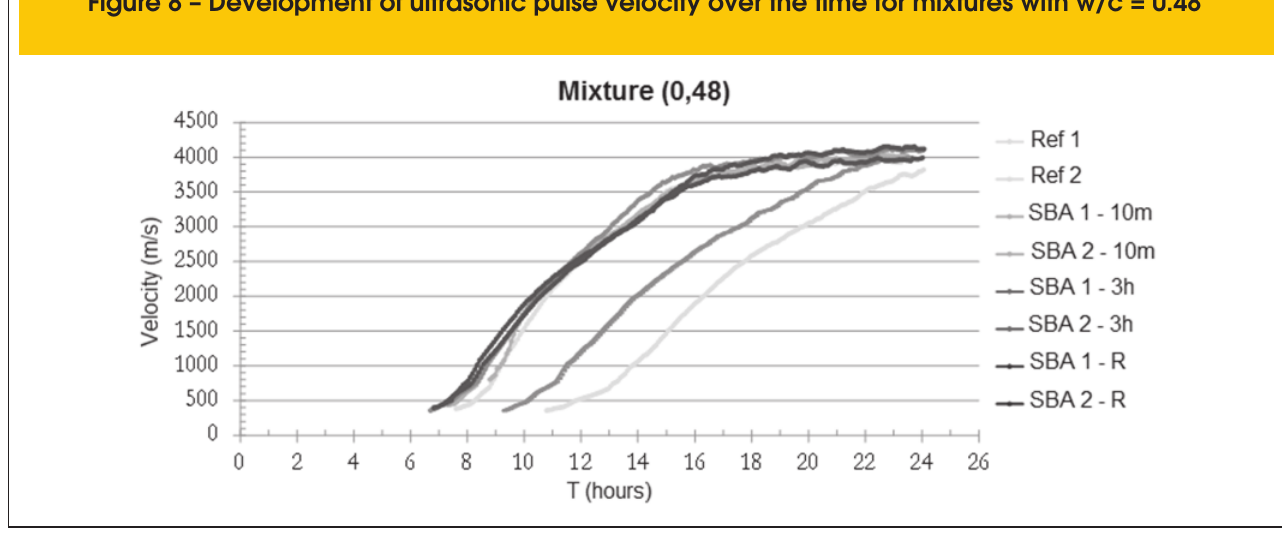
Figure 8 – Development of ultrasonic pulse velocity over the time for mixtures with w/c = 0.48